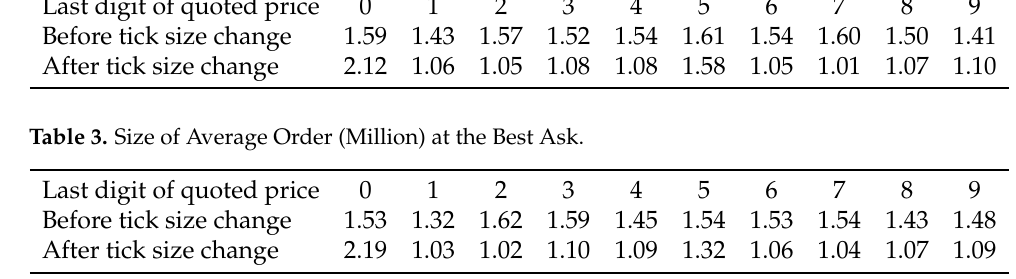
Table 2. Size of Average Order (Million) at the Best Bid. Last digit of quoted price